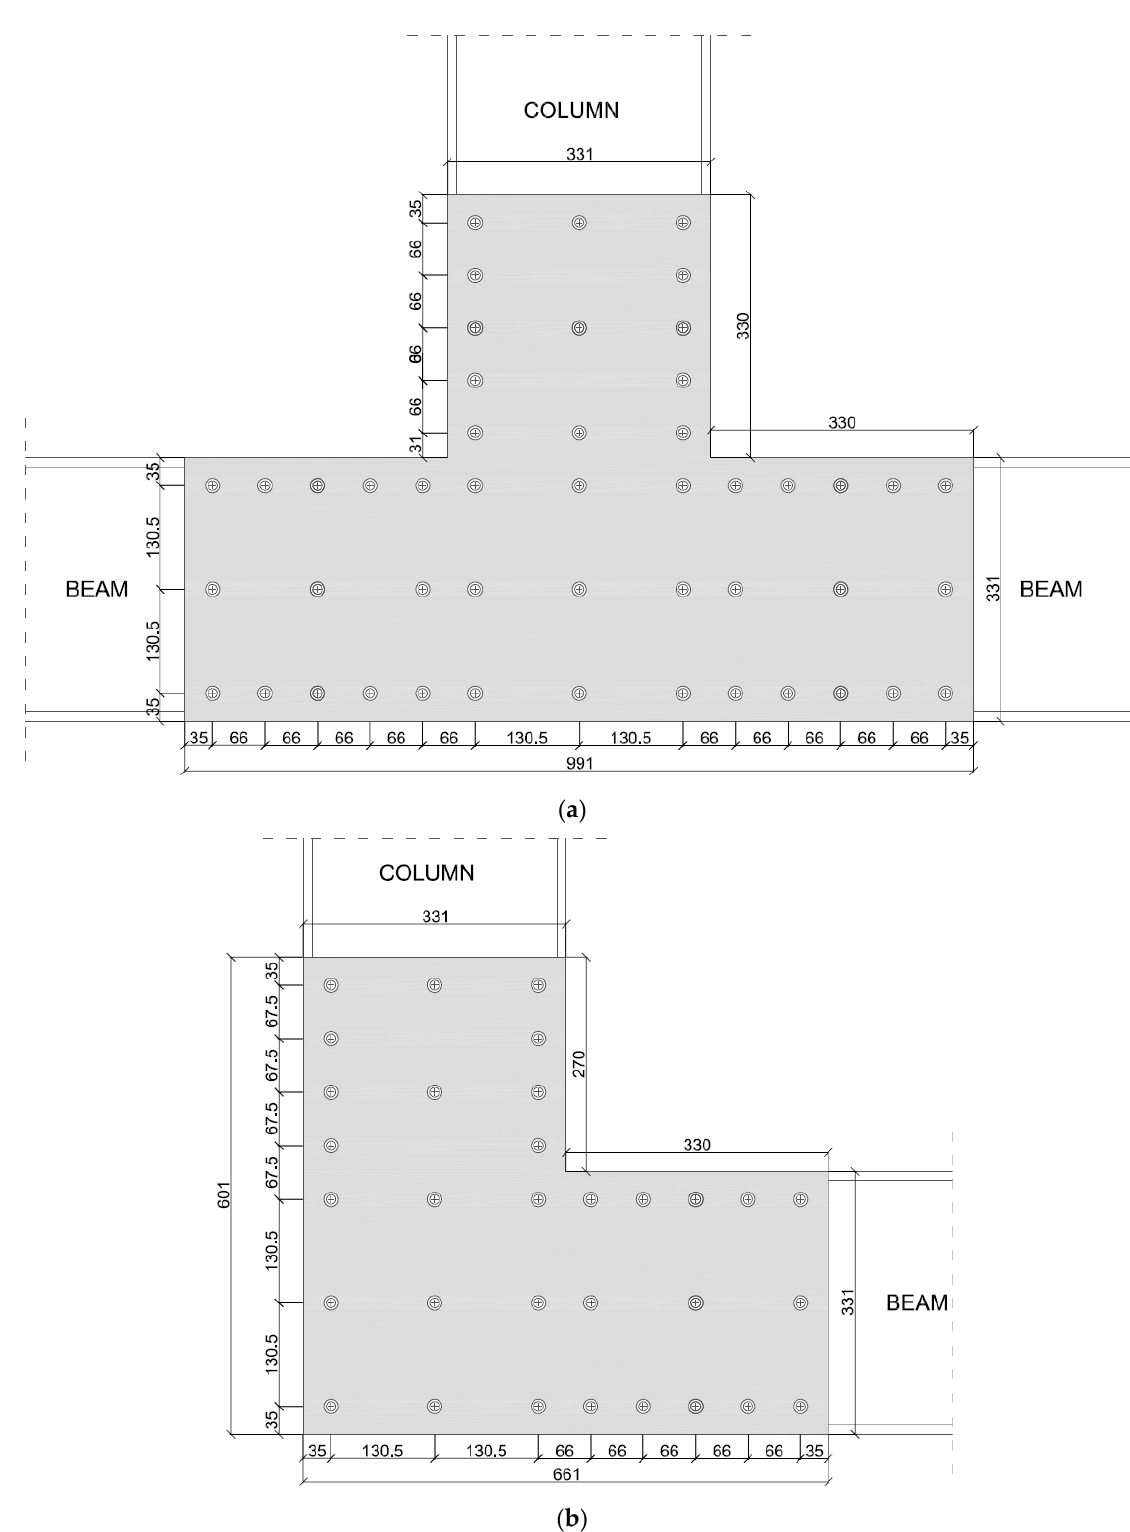
Figure 3. Close ‐ up of the joints: ( a ) T ‐ joint; ( b ) L ‐ joint (measures in mm) (centre of cross signs rep ‐ Figure 3. Close-up of the joints: ( a ) T-joint; ( b ) L-joint (measures in mm) (centre of cross signs resents the longitudinal axis of the screws). represents the longitudinal axis of the